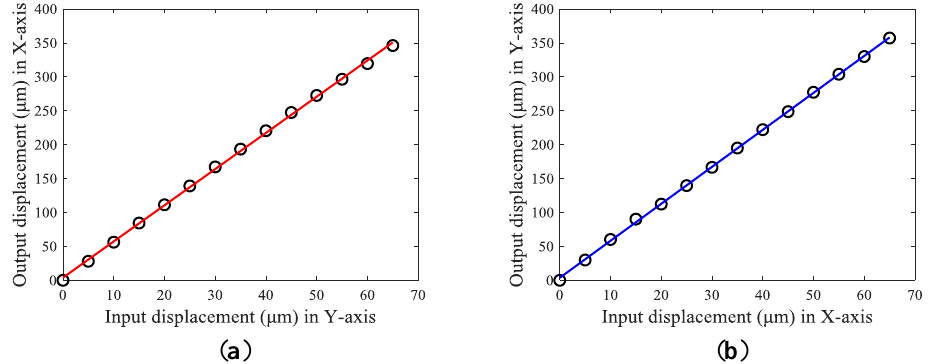
Figure 19. Experimental testing results of the stroke in ( a ) output displacement in the X-axis and ( b ) output displacement in the Y-axis.